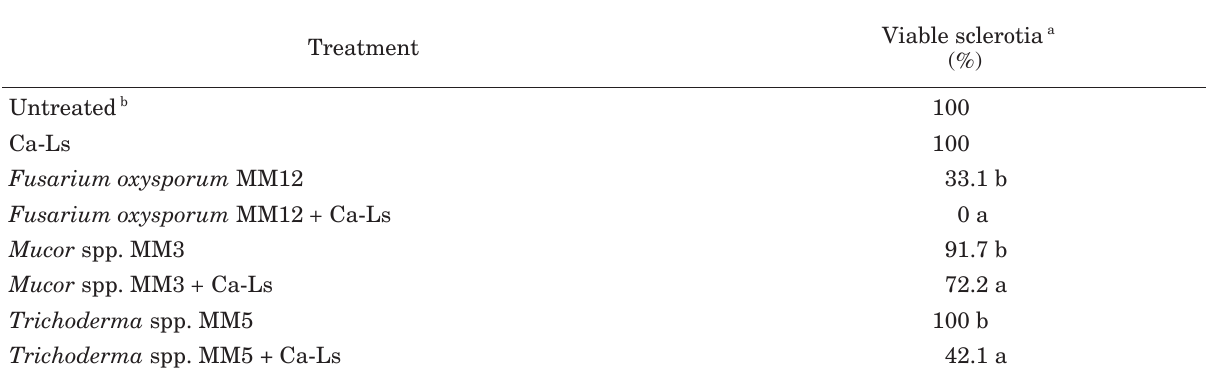
Table 4. Percent of viable sclerotia of S. sclerotiorum 30 days after their burial in sterile sand inoculated separately with fungal spores (10 6 conidia mL-1 ) of Trichoderma spp., Mucor spp. and F. oxysporum and amended or not with 1.5% (v/v) calcium lignosulphonate